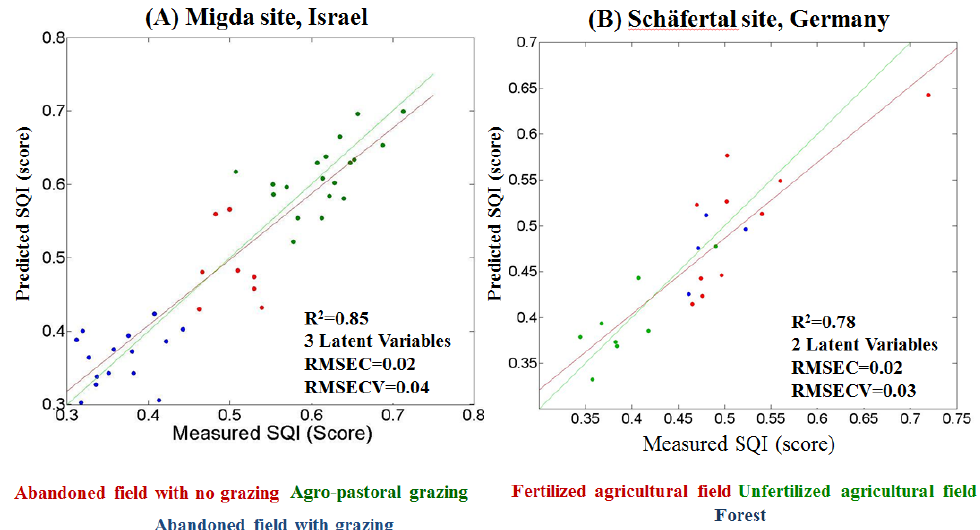
Figure 8. Scatterplot correlation of soil quality indices (SQI) and reflectance spectroscopy values from the laboratory dataset for the changed land uses: ( A ) the Migda site, Israel; and ( B ) the Schäfertal site, Germany. Calibration models were developed with a partial least squares-regression (PLS-R). RMSEC: root mean square error of calibration; RMSECV: root mean square error of cross-validation.